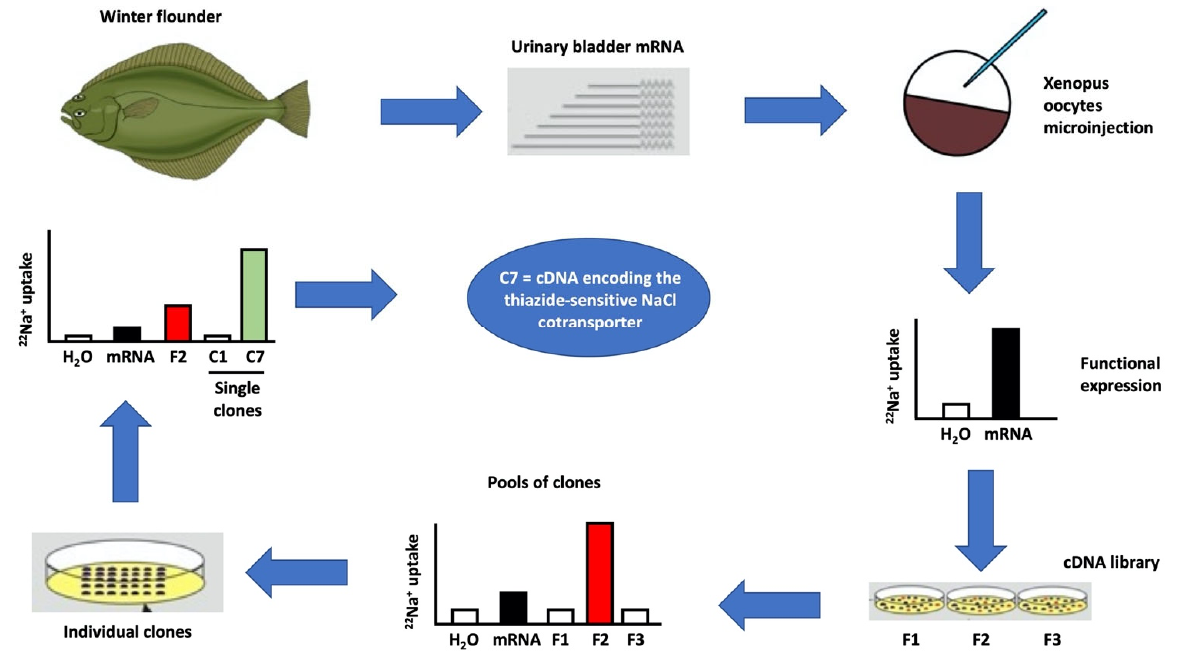
Figure 1. Expression cloning of the NaCl cotransporter, NCC. mRNA extracted from the winter flounder urinary bladder was injected into Xenopus oocytes and three days later the thiazide-sensitive and Cl − ‐ dependent 22 Na + ‐ uptake was assessed. Once the expression was established, a cDNA from the urinary bladder was constructed and filters containing about 500 clones each were prepared. Pooled bacteria for each filter were used to extract their cDNA to in vitro transcribe cRNA that was used to inject oocytes and search for NCC activity. As expected, the level of expression from the pooled bacteria was higher than from the total mRNA. Then, cloned from the positive filter were studied by groups until the cRNA transcribed from a single individual clone (C7) induced the presence of the thiazide ‐ sensitive and Cl − ‐ dependent 22 Na + ‐ uptake, which as expected was higher than that observed from the pooled clones. C7 clone cDNA encoded for NCC [13].